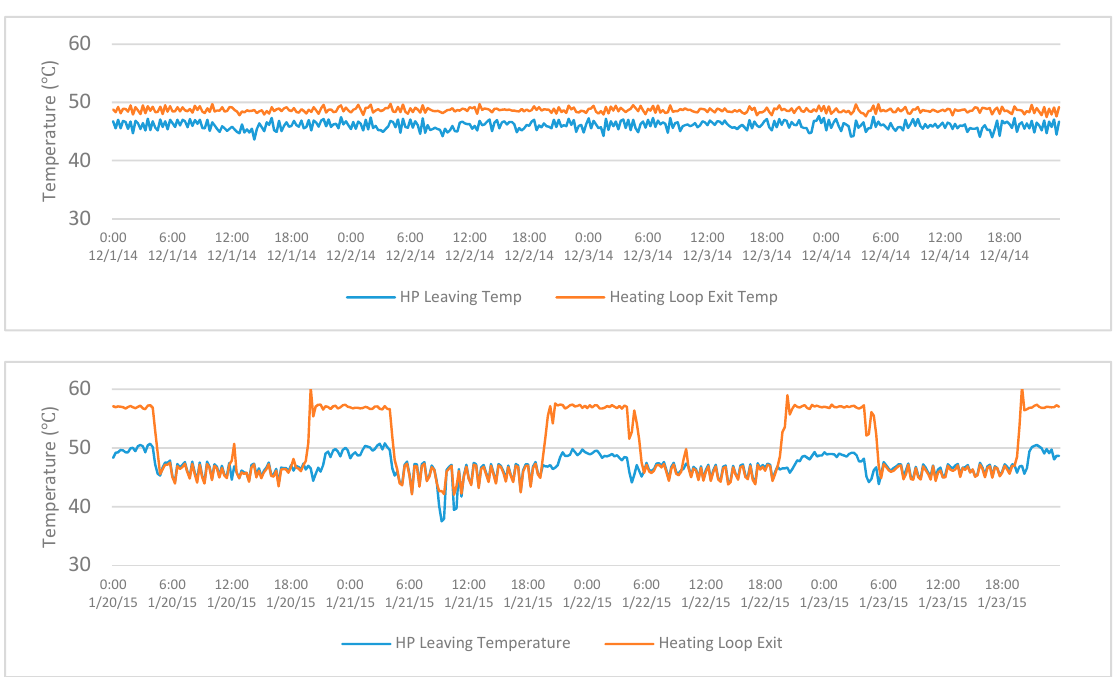
Figure 5. Hot water loop supply temperature before ( top ) and after ( bottom ) the control change.